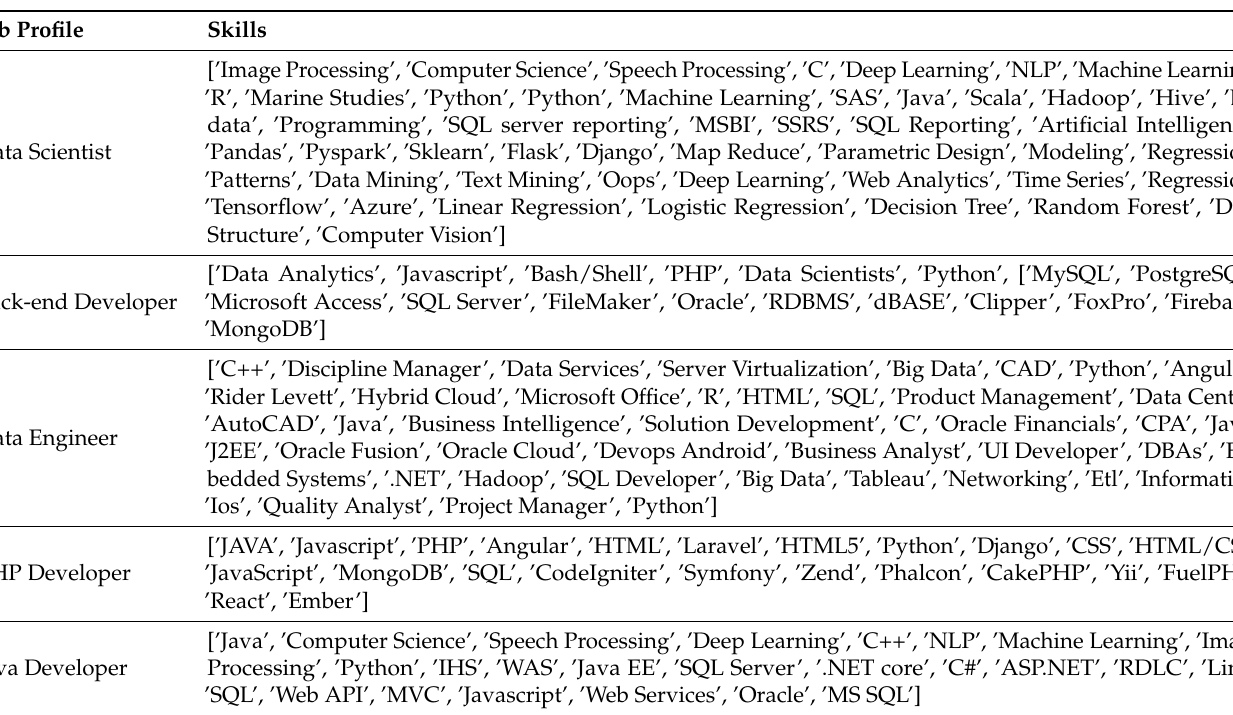
Table 3. Creating list of Saudi job profiles from scrapped data ( sa.indeed.com